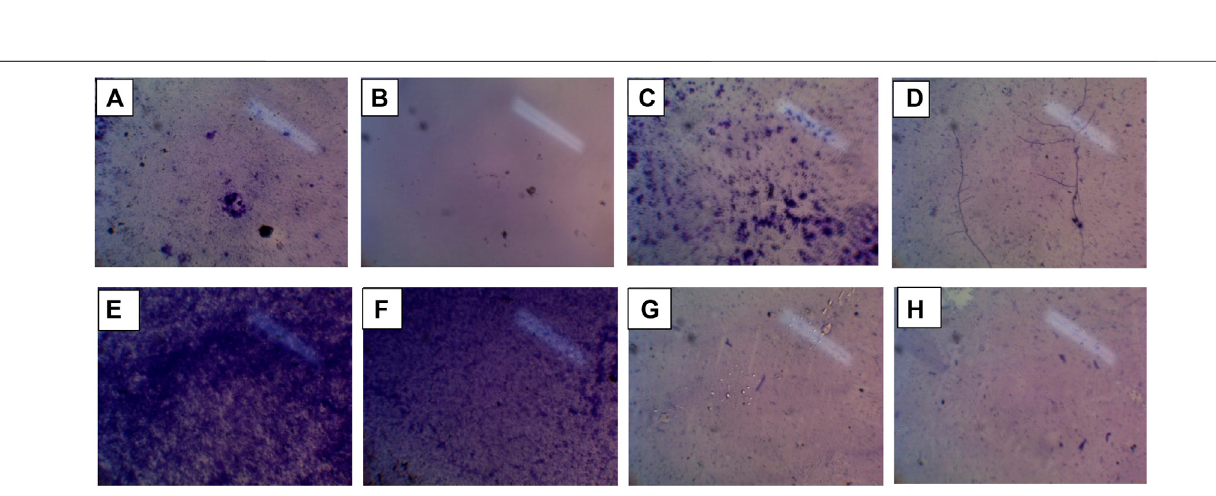
FIGURE 3 | Phase-contrast microscopy of bio fi lm inhibition (A) (Qualitative assay) inhibition of E. coli by extract fraction (min.), (B) inhibition of E. coli by nanosuspensionfraction(max.), (C) inhibitionof S.aureus byextractfraction(min.), (D) inhibitionof S.aureus bynanosuspensionfraction(max.), (E) inhibitionofnegative control against E. coli , (F) inhibition of negative control against S. aureus , (G) inhibition of positive control against E. coli , and (H) inhibition of positive control against S. aureus.